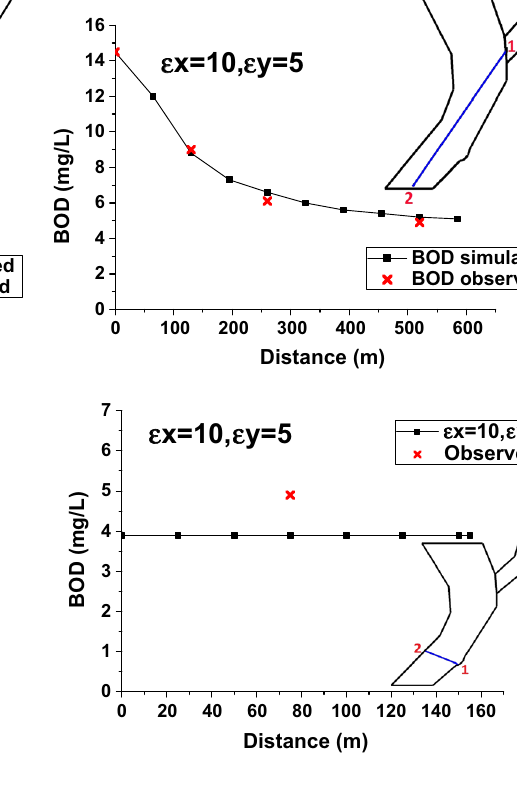
Fig. 6 Validation results of BOD (February